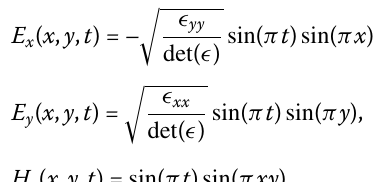
(cid:18) (cid:3) x 2 + y 2 . xy = yx =